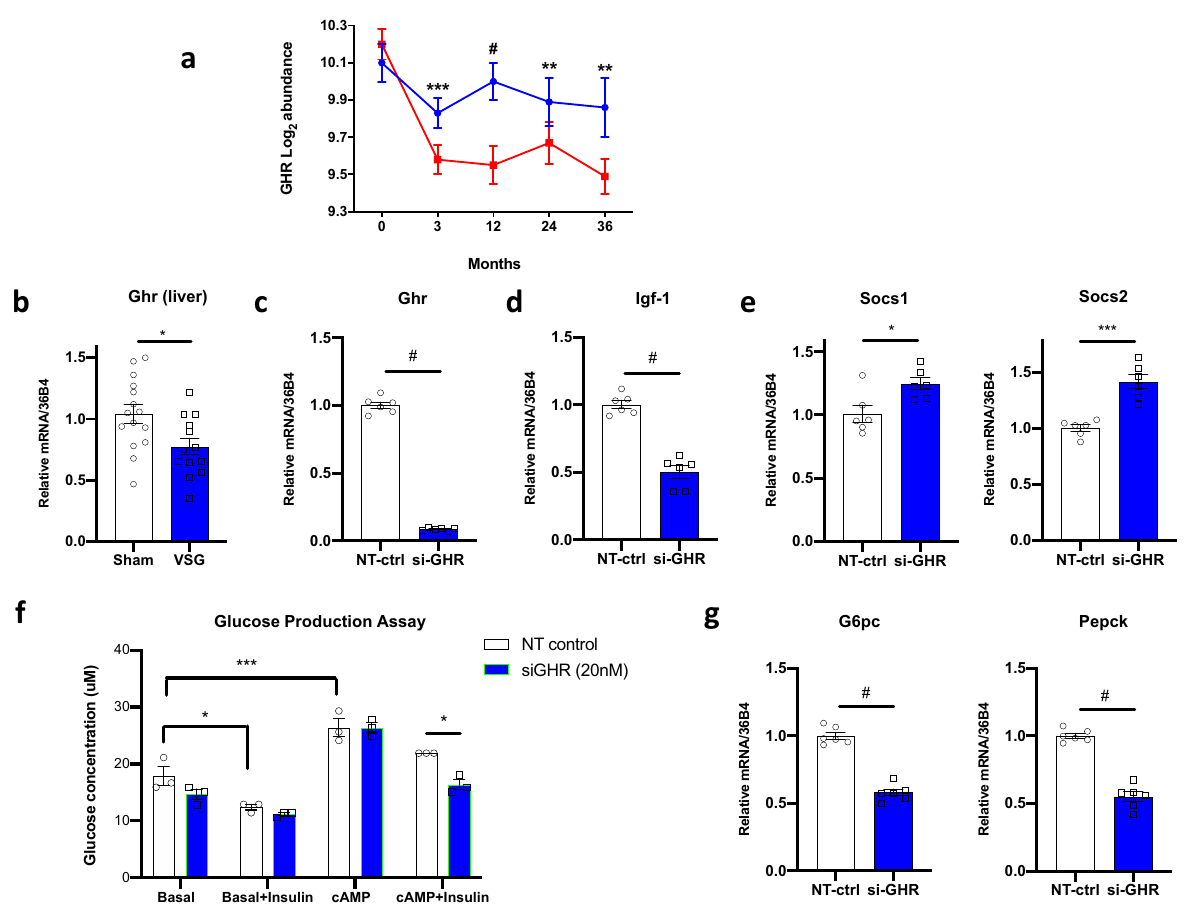
Fig. 7 GHR is reduced after bariatric surgery in humans and rodents and regulates hepatic glucose metabolism. a GHR in plasma is reduced after RYGB in humans, measured by SOMAscan in samples from independent human participants at baseline, 3, 12, 24, and 36 months from 19, 19, 16, 10, and 9 DWM and 19, 19,19, 15, and 14 RYGB participants. b Ghr expression in liver, assessed by qRT-PCR, from diet-induced obese rats, 8 weeks post-VSG bariatric surgery (VSG) or sham controls (Sham) ( n = 13 VSG, n = 15 sham). c – g Expression of GH signaling/axis genes, assessed by qRT-PCR, in cells treated with siRNA targeting Ghr (si-Ghr) or non-targeting scrambled control siRNA (NT-ctrl) ( n = 6 per group). c Ghr, d Igf-1, and e Socs1/2 in mouse primary hepatocytes treated with siRNA-Ghr or NT-control. f Glucose production in response to insulin, cAMP, and insulin/cAMP after si-Ghr or NT-ctrl. g Expression of gluconeogenic genes G6pc and Pepck in response to si-Ghr or NT-ctrl. Data are reported as mean ± SEM. For a the p -values are nominal, using a two-sided T-test; FDRs are reported in Supplementary Data 2. For b – e and g two-sided t-tests were applied; for f two-way ANOVA with Bonferroni ’ s multiple comparison test was applied in GraphPad Prism. P values are as follows: a : GHR: 3 mo: *** = 0.00099; 12 mo: #<0.0001, 24 mo: ** = 0.0024, 36 mo: ** = 0.0013. b : * = 0.0155, c : # <0.0001, d : # <0.0001; e : Socs1: * = 0.017, Socs2: *** = 0.0002; f : basal vs. insulin in NT control: * = 0.0322; basal vs. cAMP in NT control: *** = 0.0004; NT control vs. siGHR in cAMP + insulin: * = 0.0328. g : G6pc and Pepck both #<0.0001. Source data for a is provided in Supplementary Data 2. Source data for panels b – g are provided in the Source Data fi le. For expression analysis, two independent experiments were performed, while glucose production data represent a single